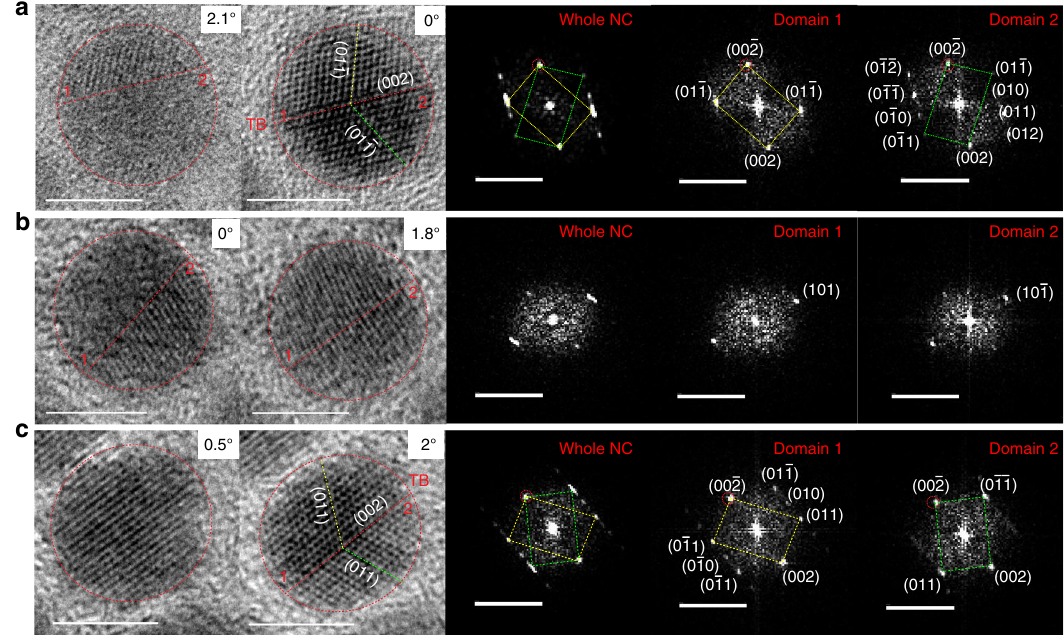
Fig. 3 Identi fi cation of twinning. Twinned domains in Cu 1.93 S NCs veri fi ed by tilt-dependent HRTEM imaging of ( a – c ) three representative NCs. From left to right: image of NC without tilt, image of the same NC after a small tilt (about an axis located in the image plane oriented ~25° clockwise with respect to the vertical direction of the image plane), fast-Fourier transform (FFT) of the whole real-space image obtained under tilt, and select-area FFTs of the individual domains, labeled 1 and 2 in the real-space image. In the real-space images, the NC boundary is marked by a dotted red circle. The twin boundary (TB) is marked by a dotted red line and the re fl ection spot corresponding to the shared twin plane is marked by a dotted red circle in the FFTs. The crystallographic planes which have a mirror relationship across the twin boundary are marked by yellow (domain 1) and green (domain 2) dotted lines in the real-space image. Corresponding reciprocal lattice patterns for the two domains are indicated in the FFTs by parallelograms of the corresponding color. Several reciprocal lattice spots are assigned to speci fi c planes of the high chalcocite phase and labeled by Miller indices. Scale bars in real-space images are 5 nm in length and those in FFTs are 5 nm −